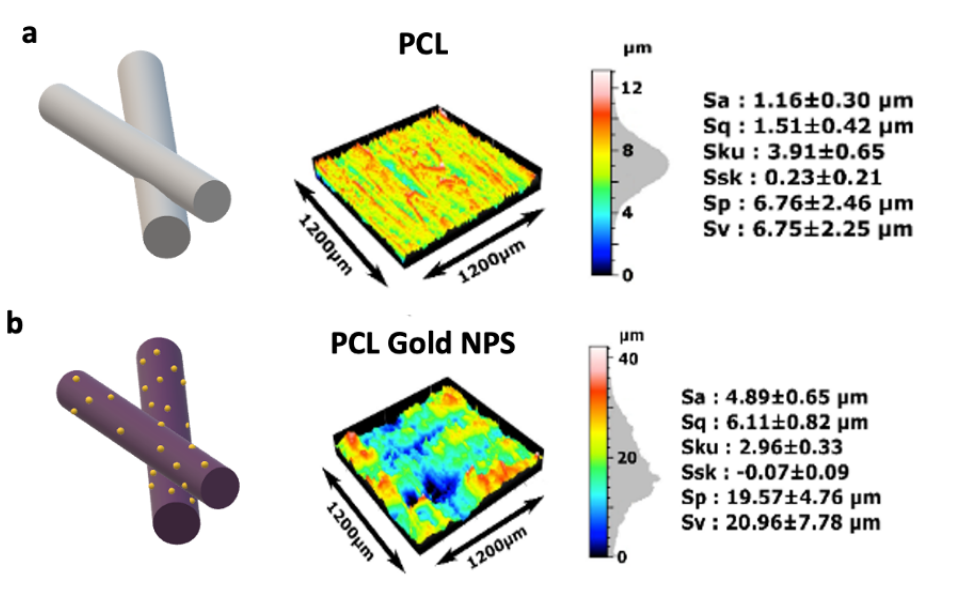
Figure 3. Topography of the PCL scaffolds coated or not with gold nanoparticles. Sensofar Confocal profiler measurement of the surface of ( a ) PCL and ( b ) PCL coated with gold nanoparticles. The features used to evaluate the surface roughness of the material were height parameters (Sv), valleys and peaks (Sp), including arithmetical mean height (Sa), and root mean square height (Sq). Skewness (Ssk) represents the degree of symmetry of the surface heights about the mean plane, while kurtosis (Sku) indicates the randomness of height and the sharpness of the structures on the surface ( n = 3 for each